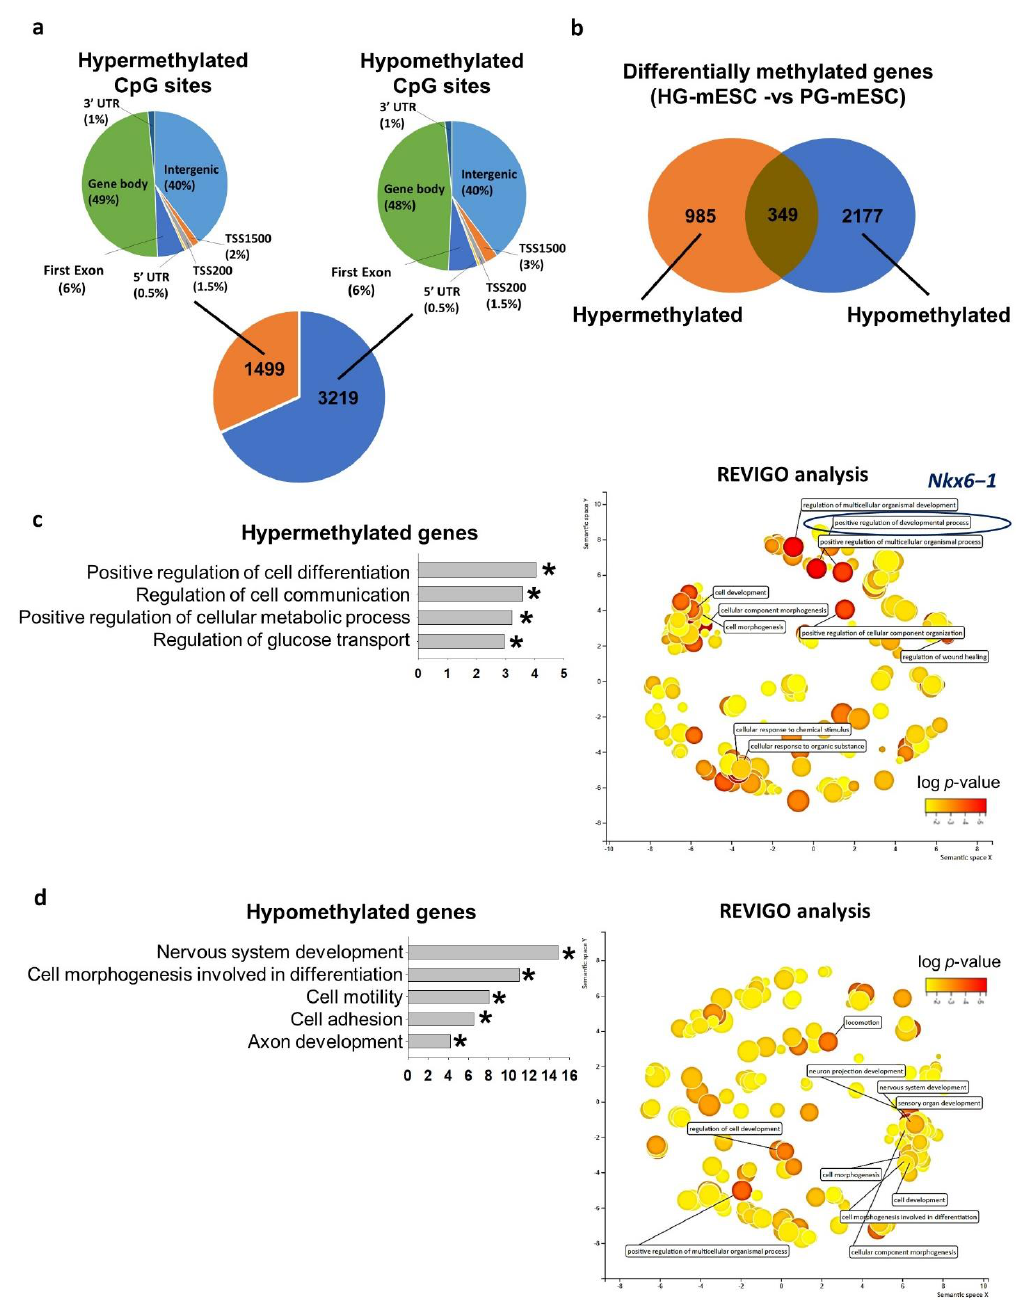
Figure 5. Conventional hyperglycemic culture condition dysregulated mouse ESC DNA methylome related to metabolism and glucose transport. ( a ) Number of differentially methylated CpG sites in mESC derived under hyperglycemic condition (HG-mESC: 25 mM), while the control was mESC derived under physiological glucose condition (PG-mESC: 5.5 mM) and their genomic distribution. UTR: untranscribed region, TSS1500: 1500 bp upstream of transcription start site, TSS200: 200 bp upstream of transcription start site. ( b ) Number of differentially methylated genes in HG-mESC. ( c ) ( left ) Gene ontol- ogy analysis of the hypermethylated genes. (*: p < 0.05), ( right ) Cluster-plot of gene ontology terms processed with REV- IGO analysis. Top 10 grouped gene ontology terms were shown. ( d ) ( left ) Gene ontology analysis of the hypomethylated